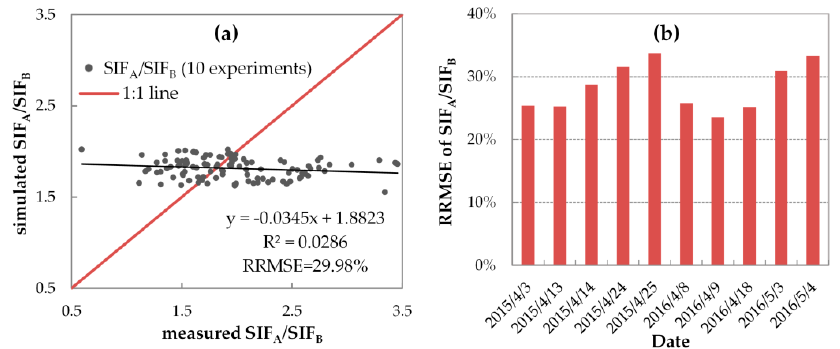
Figure 10. The correlation and relative root mean square error (RRMSE) values between simulated and measured SIF A /SIF B with fixed FQE: ( a ) the correlation and RRMSE for 106 spectral measurements and ( b ) the RRMSE values for each fieldwork day in 2015 and 2016.